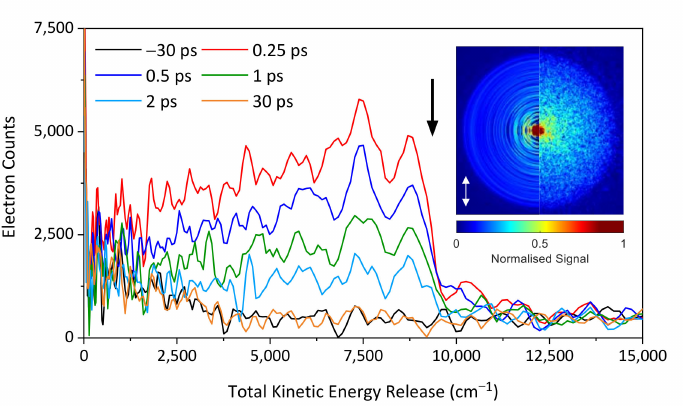
Figure 4. Total kinetic energy release (TKER) spectra of p -HMC obtained using the 308.5 nm pump and 240 nm probe with a 1.5 bar helium backing pressure. The following pump-probe time delays are used: ∆ t = − 30, 0.25, 0.5, 1, 2 and 30 ps and an expected TKER max of around 9360 cm − 1 is indicated by the black arrow. Inset: right half presents the recorded image, while the left half presents the reconstructed slice through the centre of the original three-dimensional (3D) ion distribution at ∆ t = 0.25 ps (the white arrow indicating the electric field polarisation of the laser pulses). The polarisations of the pump and probe beams were parallel with respect to each